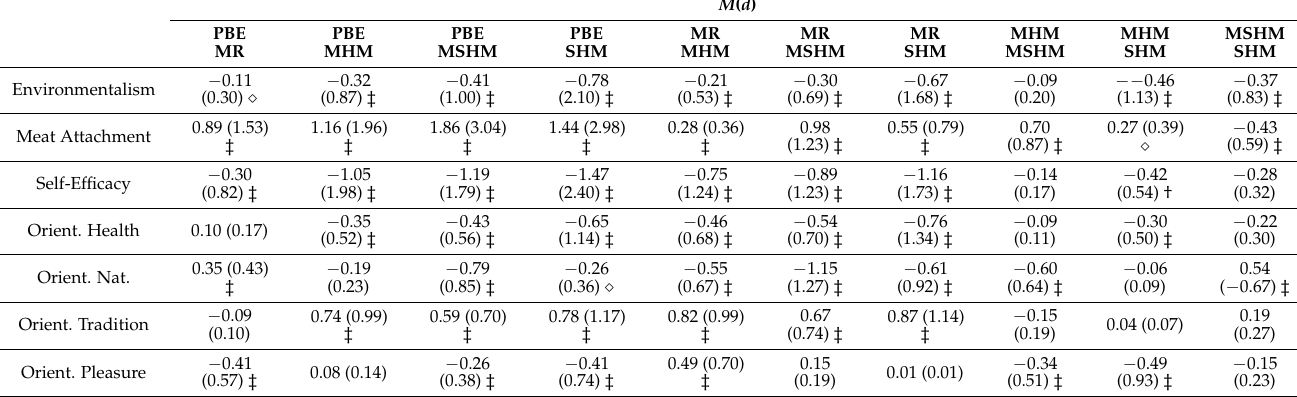
Table A2. Results of post-hoc tests using Benjamini-Hochberg correction for profiling